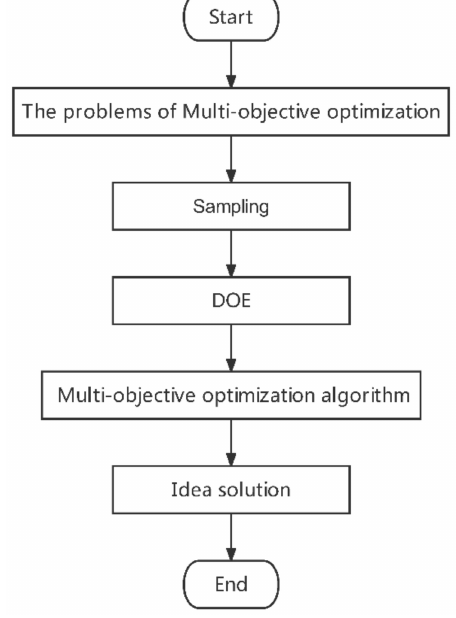
Figure 20. Multi-objective optimization